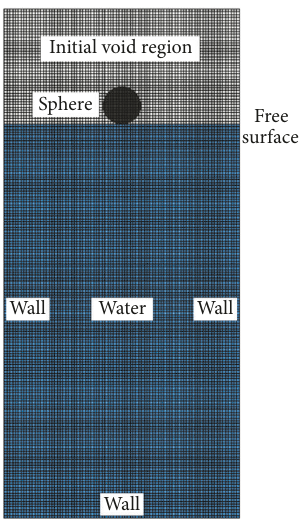
Figure 2: The computational domain, boundary conditions, and grid distribution for the water entry problem of